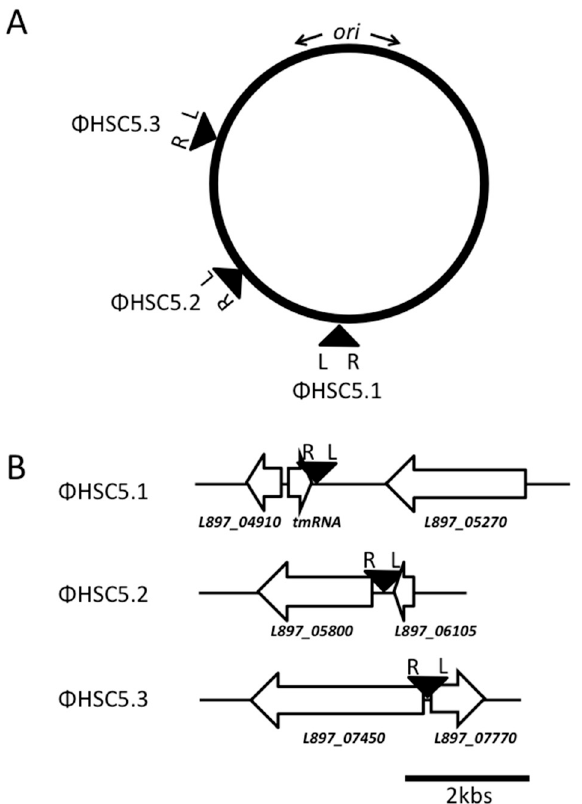
Figure 4. Prophage integration sites on the chromosome of Streptococcus pyogenes HSC5. ( A ) Positions of prophages on the S. pyogenes HSC5 genome. The circle represents the S. pyogenes chromosome. ori indicates the chromosomal replication origin for bidirectional DNA synthesis. The positions of the prophages, Φ HSC5.1, Φ HSC5.2, and Φ HSC5.3 on the chromosome are 31.8 min, 37.3 min, and 48 min, respectively. Inverted triangles indicate integration sites of the prophages. L denotes the position of att L next to integrase genes, and R denotes att R next to paratox genes; and ( B ) prophage integration sites in the HSC5 genome. White arrows indicate ORFs identified by locus tags (L897 numbers) of the S. pyogenes HSC5 genome.